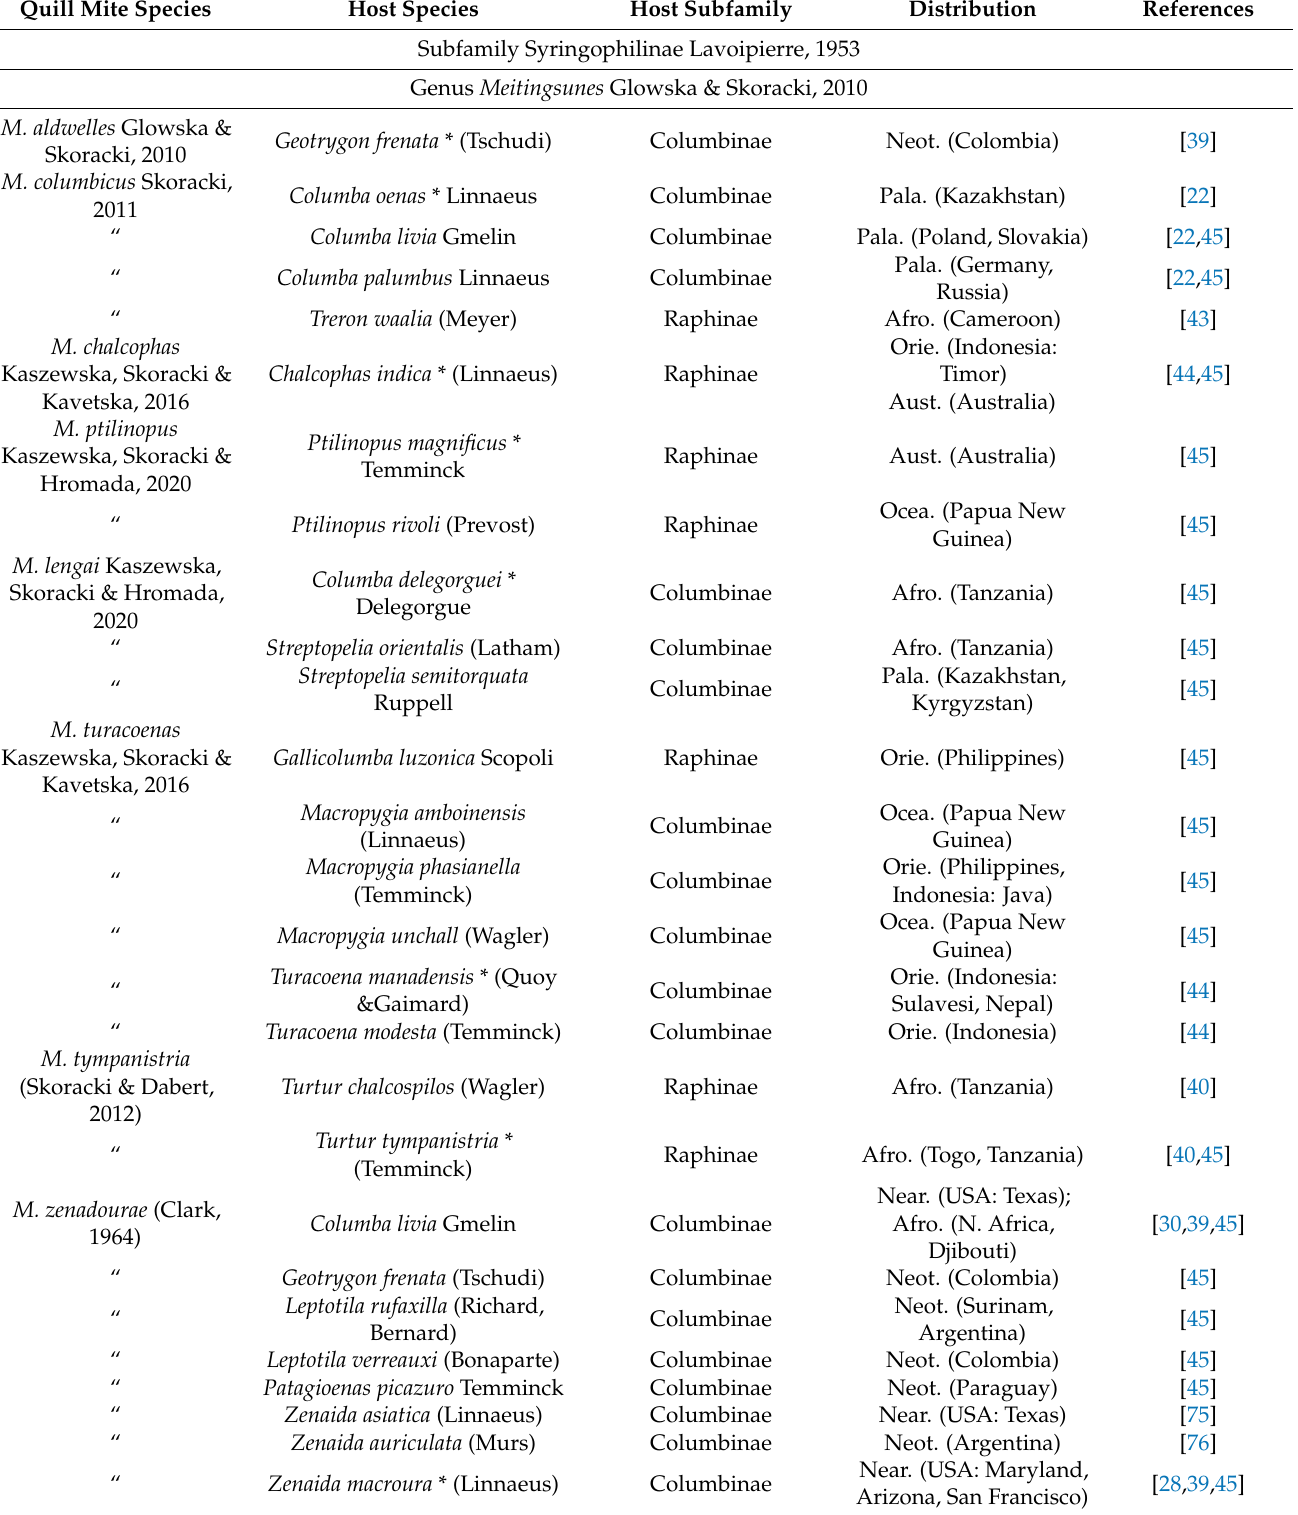
Table 1. Quill mite species of the family Syringophilidae parasitizing birds of the order Columbiformes with their